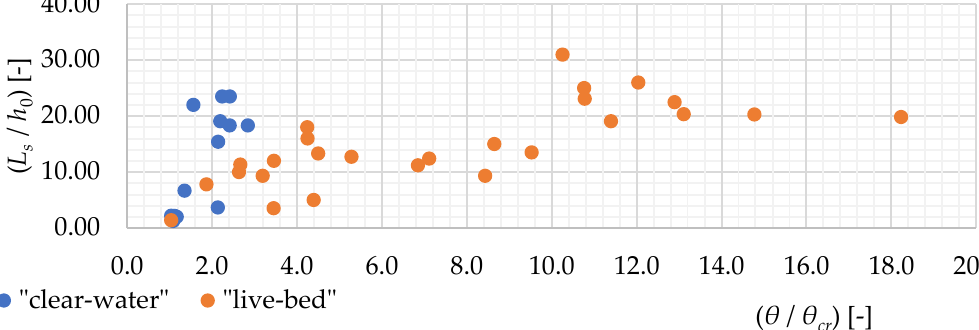
Figure 16. Bed shear stress θ to critical shear stress θ cr ratio, and scour length L s to initial water depth Figure 16. Bed shear stress 𝜃 to critical shear stress 𝜃 𝑐𝑟 ratio, and scour length L s to initial water h 0 Figure 16. Bed shear stress 𝜃 to critical shear stress 𝜃 𝑐𝑟 ratio, and scour length L s to initial water depth h 0 correlation. depth h 0 correlation. Figure 16. Bed shear stress 𝜃 to critical shear stress 𝜃 𝑐𝑟 ratio, and scour length L s to initial water depth h 0 correlation.